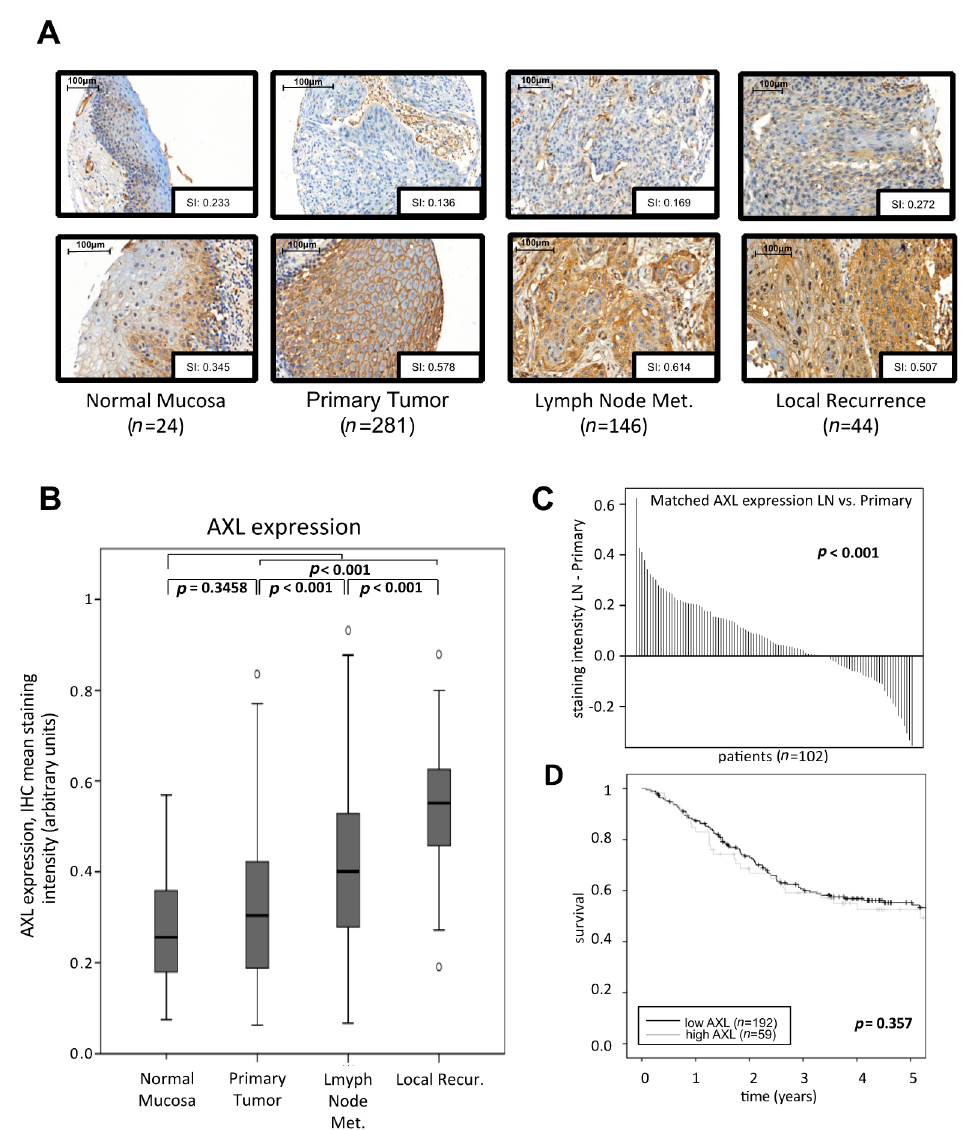
Figure 1. AXL expression in HNSCC patients. ( A ) IHC following staining for AXL. For each manifestation, representative cores with negative/weak ( top row) or strong expression ( bottom row) are shown. Expression is quantified by the mean membranous staining intensity (SI, arbitrary units) in the sample as calculated by the Definiens software; ( B ) summary of AXL protein expression by tumor stage; ( C ) difference in AXL expression between matched lymph node metastases and primary tumors was significantly higher in lymph node metastases compared to their matched primary tumor; and ( D ) Kaplan–Meier estimates for overall survival of patients in the highest quartile of AXL expression ( high AXL) compared to all other patients ( low AXL). Result of the univariate log-rank test is indicated. HNSCC, head and neck squamous cell carcinoma; IHC, immunohistochemistry; LN, lymph node metastases.